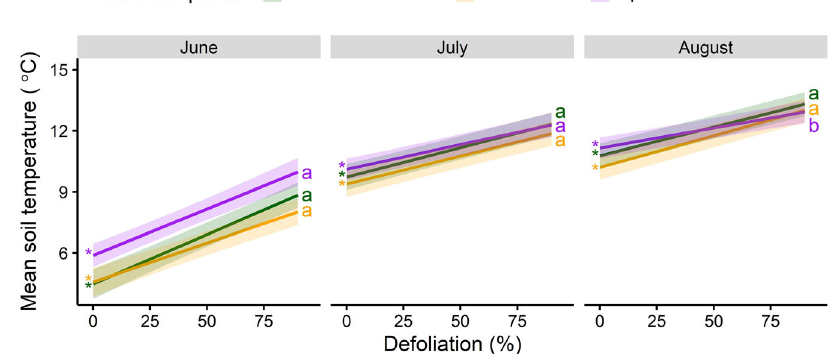
Fig. 5 Change in soil temperature with annual progression of the outbreak. Fitted relationships between soil temperature under the humus layer and local mean tree defoliation within a 5 m-radius and stand composition. Shaded areas indicate 95% con fi dence intervals. Slopes signi fi cantly different from zero are represented by an asterisk and letters compare slopes among stand composition types, separately for each month. The linear mixed-effect model was fi tted on 3459 observations.